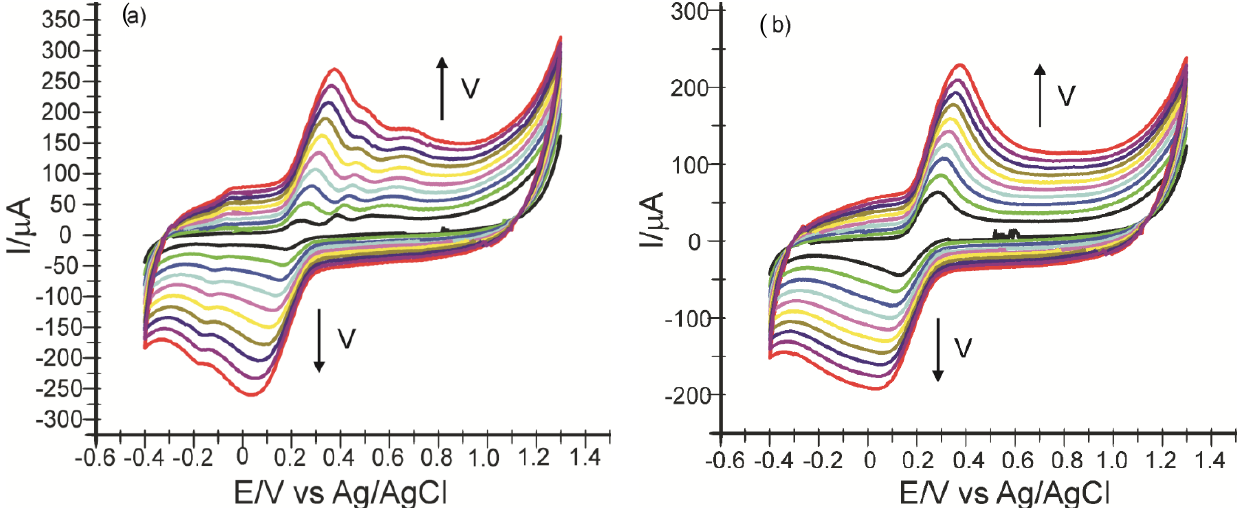
Figure 3. Cyclic voltammograms recorded, at different scan rates (0.1–1.0 V·s − 1 ), of CNF/SPE immersed one at a time in 10 − 3 M ferulic acid solution ( a ) and 10 − 3 M caffeic acid solution ( b ).